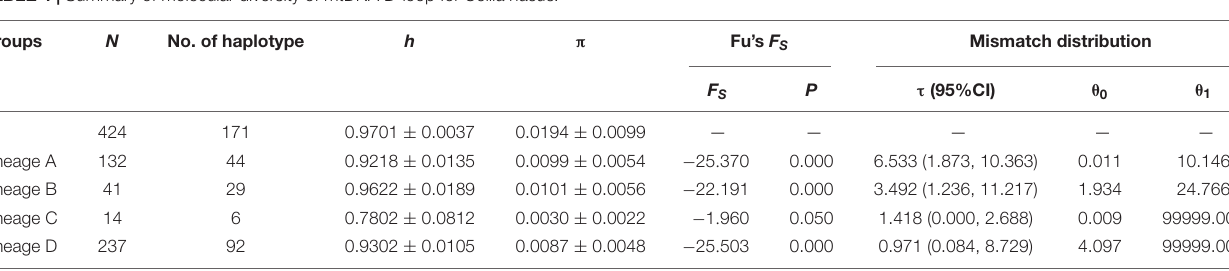
TABLE 4 | Summary of molecular diversity of mtDNA D-loop for Coilia